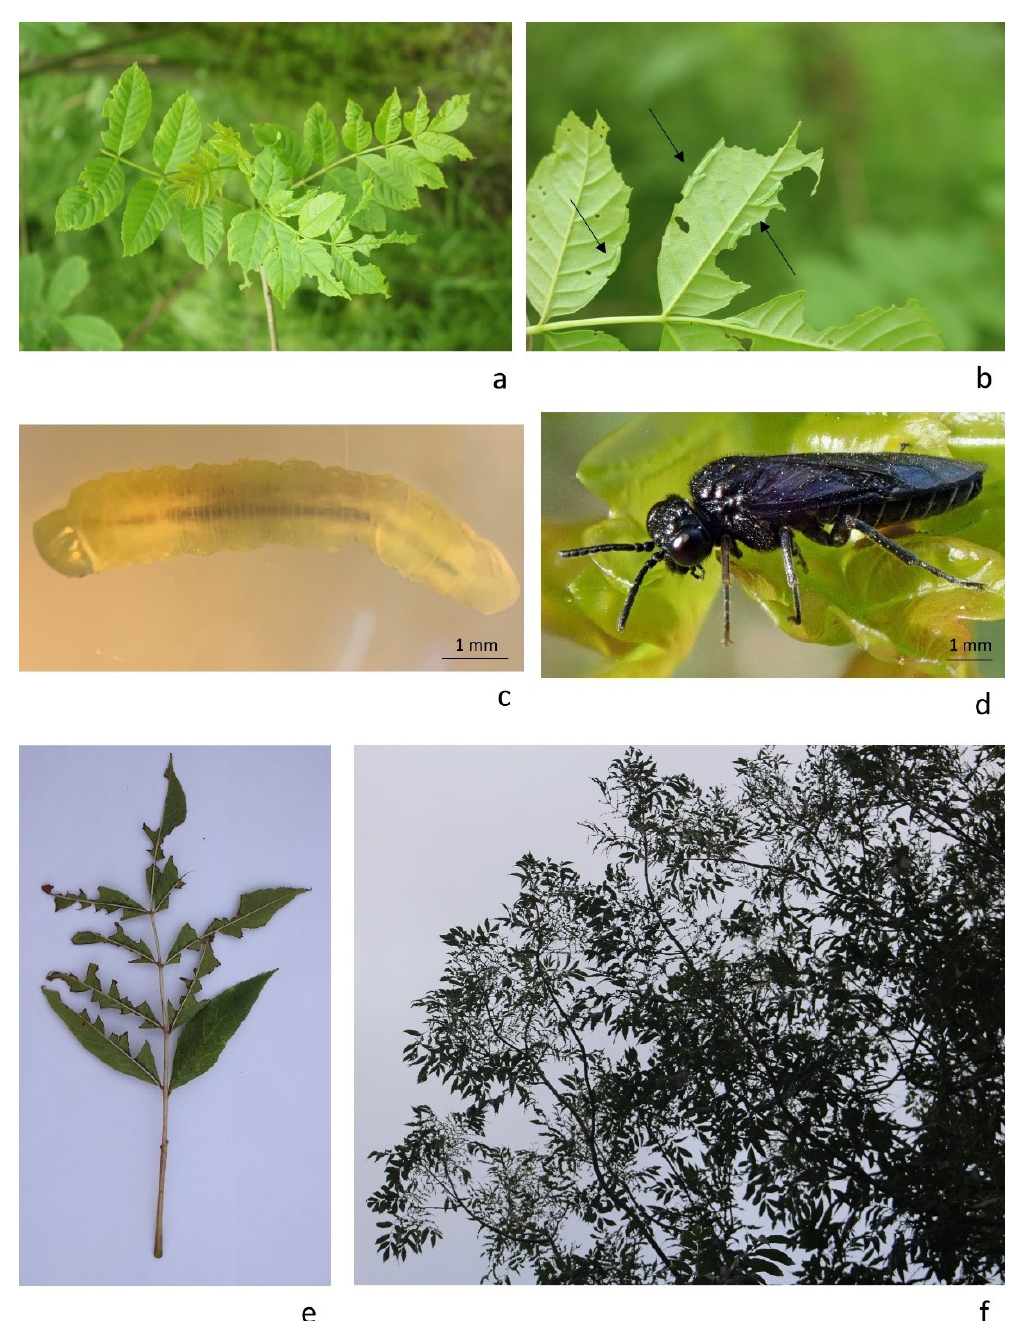
Figure 1. Tomostethus nigritus in the Republic of Ireland. ( a , b ) Leaves damaged by T. nigritus on F. excelsior in Co. Kildare and observation of larvae on the underside of the leaves (indicated by the black arrows) (Carbury, Co Kildare, Ireland, 08.VI.21, photo A.M.M. Tiley); ( c ) image of T. nigritus larvae (Trinity College Dublin, Dublin, Ireland, 09.VI.21, photo E. Fuller; ( d ) adult of T. nigritus observed in Belfast (NI) (Belfast, UK, photo A.K. Murchie); ( e , f ) detail of defoliated ash leaves by T. nigritus in Co. Dublin. Only the main vein of the leaf remained intact and attached to the branches (Kimmage, Dublin, Ireland, 17.X.21, photo A.M.M. Tiley ).